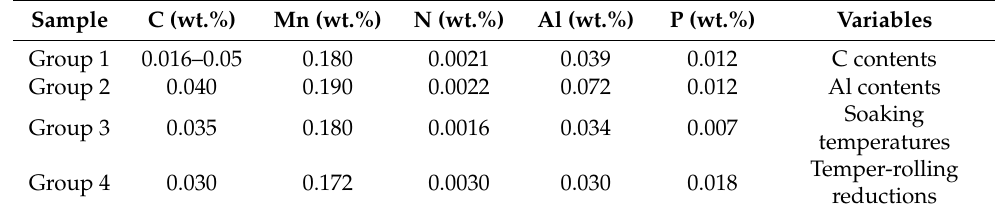
Table 1. Nominal compositions of the CQ strip samples used in this work (all in weight percentage). Sample C (wt.%) Mn (wt.%) N (wt.%) Al (wt.%) P (wt.%) Group 1 0.016–0.05 0.180 Group 2 0.040 Group 3 Group